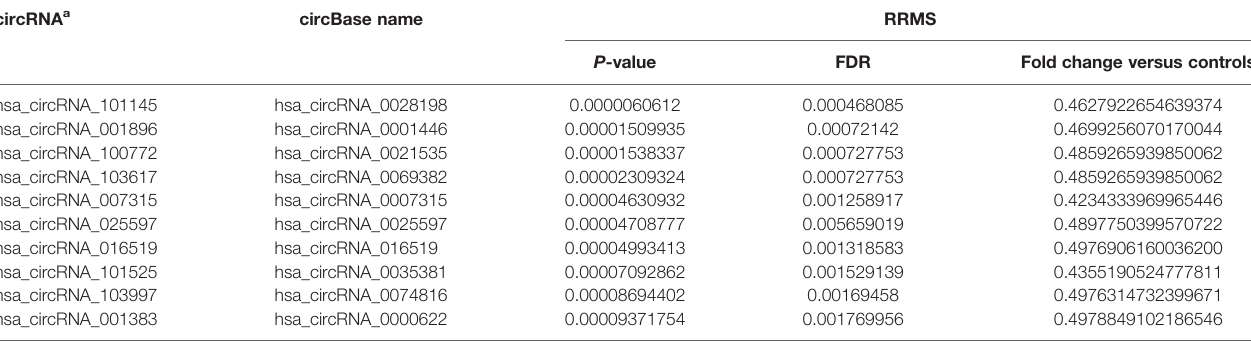
TABLE 2 | List of the 10 selected circRNAs differentially downregulated in RRMS versus healthy